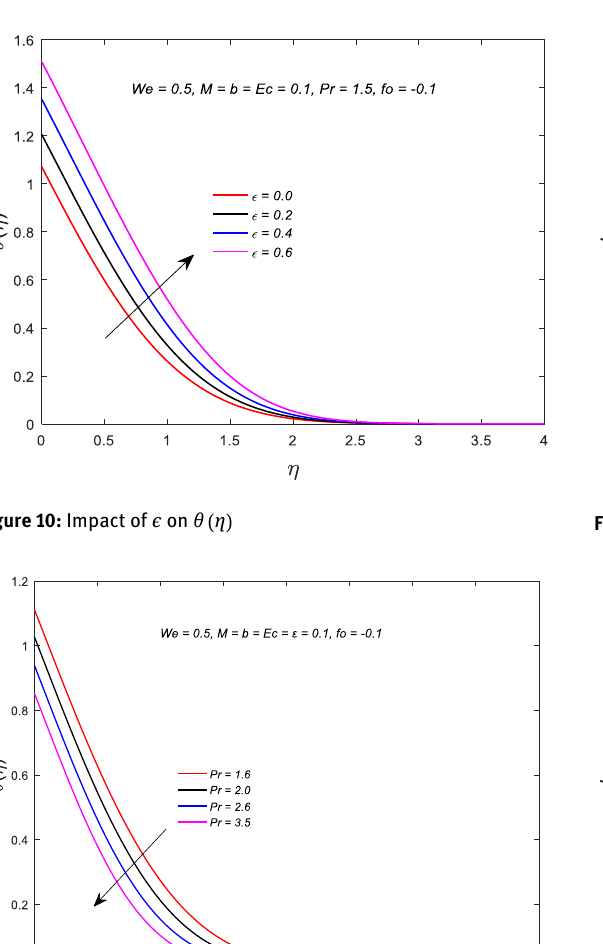
Figure 9: Impact of M on θ ( η )